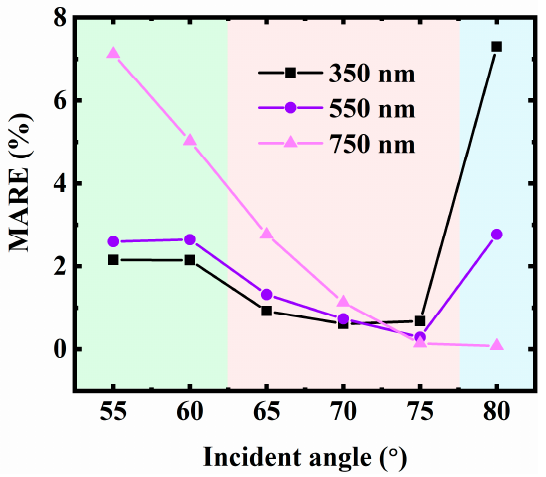
Figure 6. Values of MARE versus the incident angle at three wavelengths.